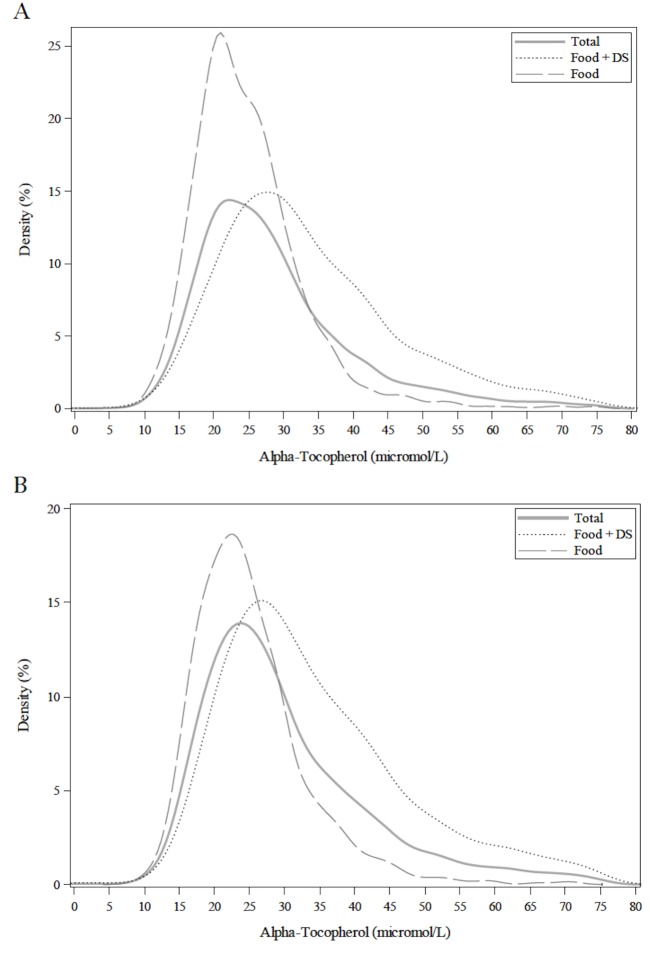
Distribution of serum α-tocopherol concentrations among individuals ≥20y, excluding pregnant or lactating women, stratified by sex and supplement use.A. Males. B. Females. Lines represent density (as a percentage) through non-parametric kernel density estimation.